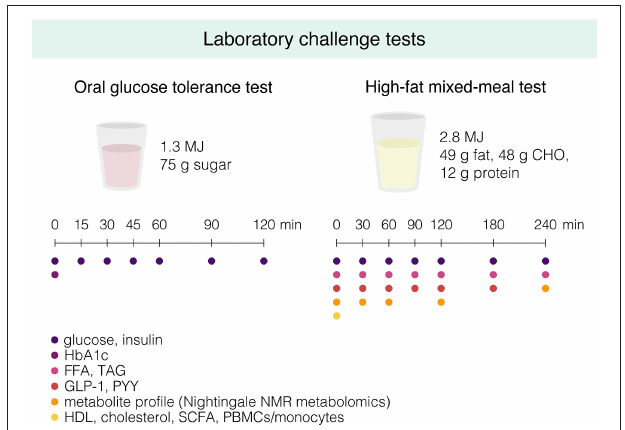
FIGURE 4 | Graphical overview of the oral glucose tolerance test and the high-fat mixed-meal (HFMM) test that are performed during the pre- and post-intervention characterization week. Participants are instructed to drink the glucose drink or HFMM within 5min, and fasting and postprandial blood samples are drawn at the indicated timepoints for determination of the indicated metabolites. CHO, carbohydrates; HbA1c, hemoglobin A1c; FFA, free fatty acids; TAG, triglycerides; GLP-1, glucagon-like peptide 1; PYY, peptide YY; NMR, nuclear magnetic resonance; HDL, high-density lipoprotein; SCFA, short-chain fatty acids; PBMCs, peripheral blood mononuclear